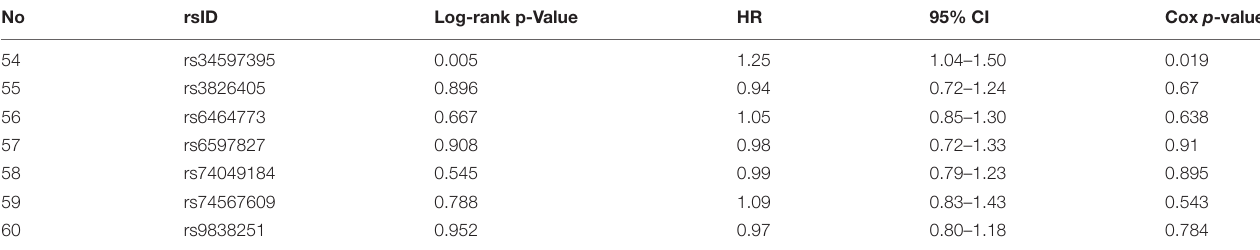
gene expression compared to the TT or CT genotype (for ( Figure 3B and Table 3 ). Moreover, compared to the CC or CA genotype, the rs34597395 AA genotype is significantly associated with decreased PAK4 gene expression in LIHC patients ( p = 1.0 × 10 − 8 ) ( Figure 3C and Table 3 ). On the contrary, there is obviously increased RAG1 gene expression in the rs35624901 Del.Del genotype carriers compared with that in individuals with the TT or T.Del genotype ( p = 1.6 × 10 − 4 ) ( Figure 3D and Table 3 ). Evident associations between these four genetic variants and OS of TCGA LIHC patients are also observed ( Table 3 ). The median overall survival time (MST) of LIHC patients carrying the rs12574873 CC, CA, or AA genotype is 13.35, 19.5,